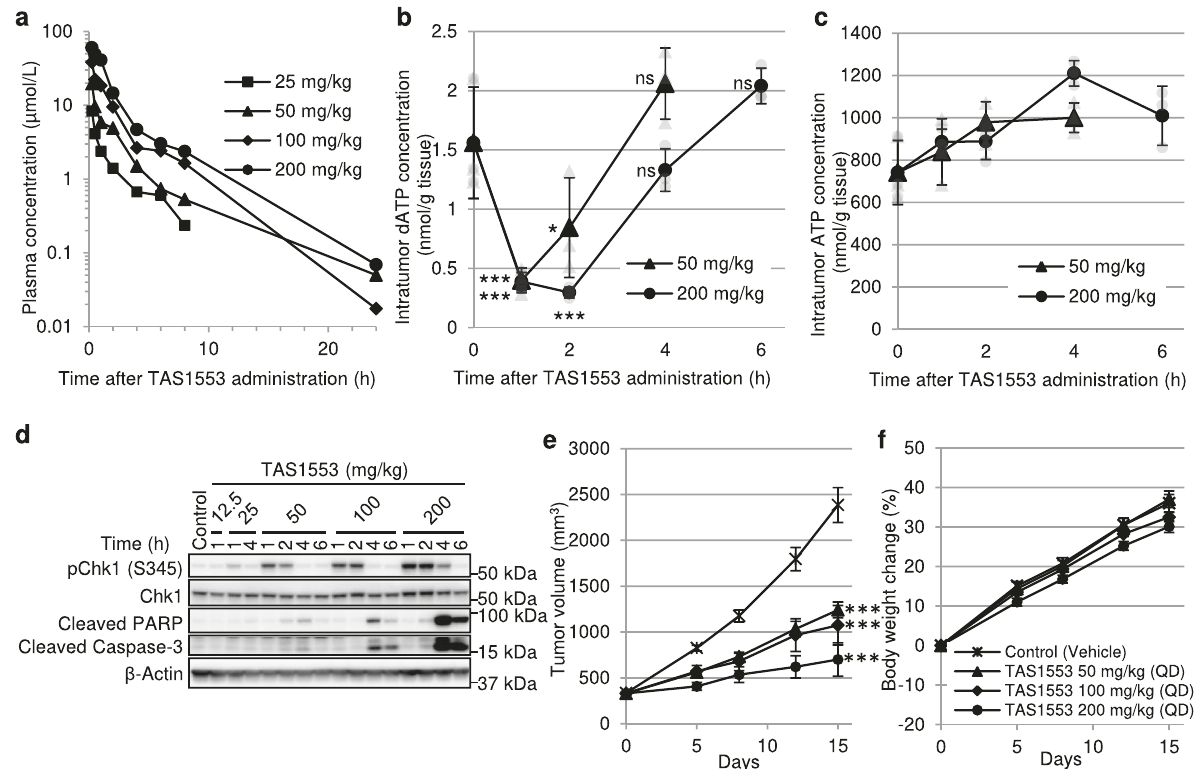
Fig. 4 In vivo pharmacodynamic effect and antitumor ef fi cacy of TAS1553. a Plasma concentration of TAS1553 in nude rats after oral administration. Average concentrations shown at each point ( N = 2). b , c Effect of TAS1553 oral administration on the intratumoral dATP pool ( b ) and ATP pool ( c ) in MV-4-11 xenograft tumors. Data are presented as the mean ± SD ( N = 3). d MV-4-11 xenograft tumors were collected and the expression of indicated proteins was analyzed by immunoblotting. e , f Inhibition of tumor growth ( e ) and body weight change ( f ) in rats bearing MV-4-11 xenografts over a 14-day treatment with oral TAS1553. Data are presented as the mean ± SEM ( N = 5). * P < 0.05 and *** P < 0.001 versus control group. ns not statistically signi fi